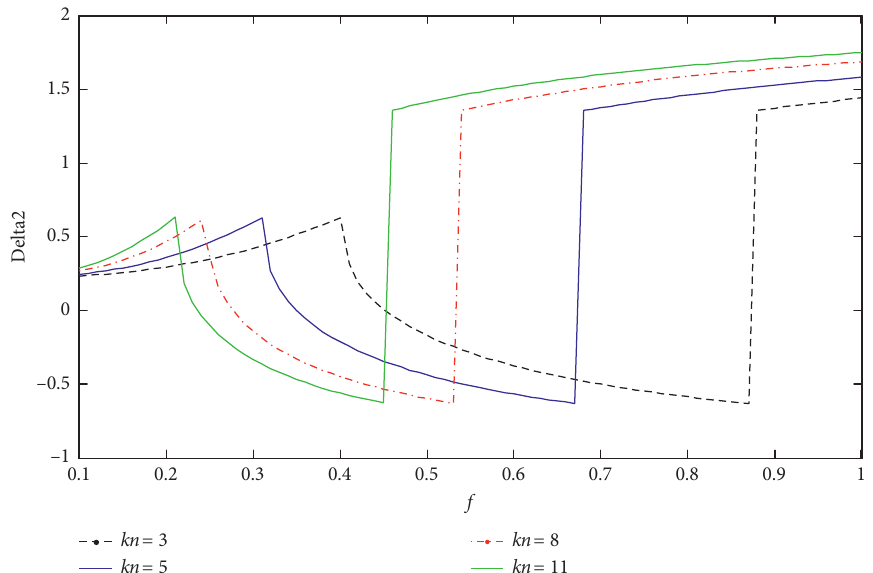
Figure 19: NES phase δ